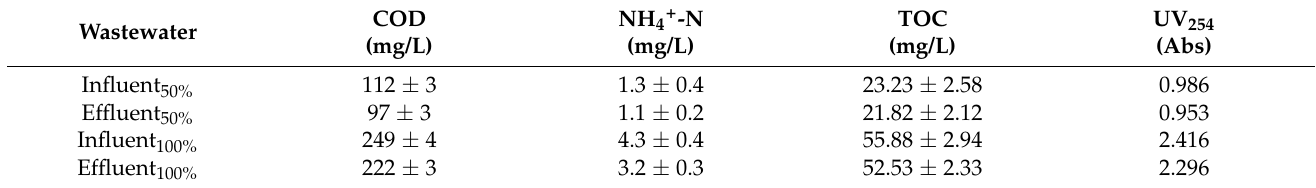
Table 1. Characteristics of the influent and the effluent of the SBR during the acclimation process.